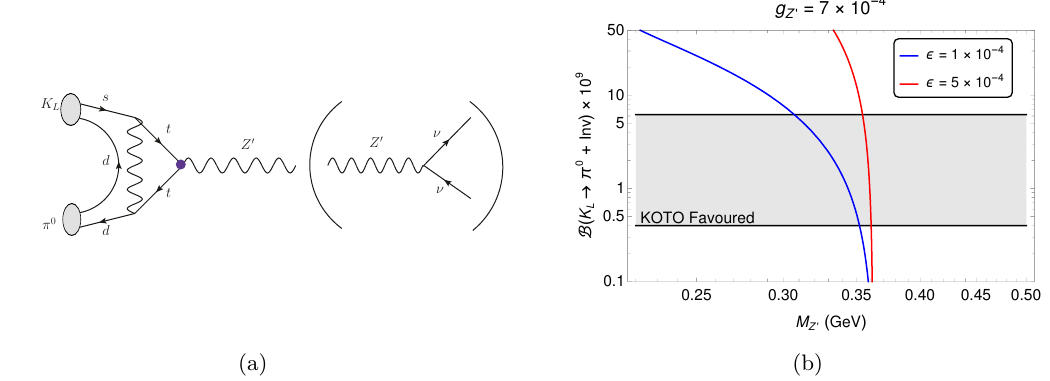
Figure 28 . (a) The diagram that will contribute to K L → π 0 νν decays. (b) Variation of the branching fraction of K L → π 0 + Inv with the mass M Z 0 for different values of the kinetic mixing parameter (cid:15) . The grey band represents the meaured value of B ( K L → π 0 ν ¯ ν )